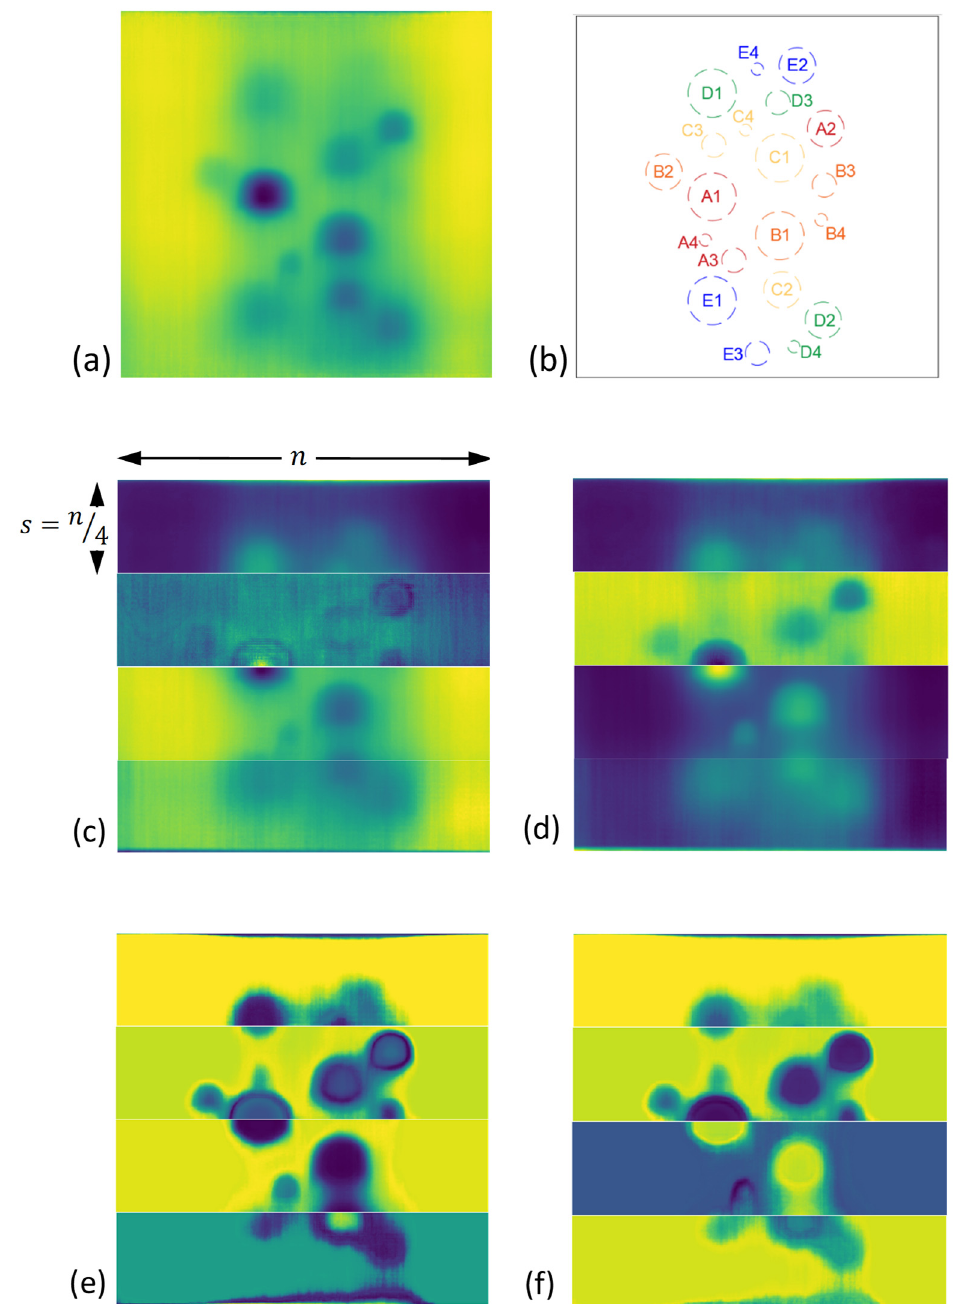
Figure 11. ( a ) the test piece original full-frame thermal image; ( b ) defects schematic; ( c , d ) the first and second PCA of original time-transient thermal images; ( e , f ) the first and second PCA of time-transient DRR selected images.